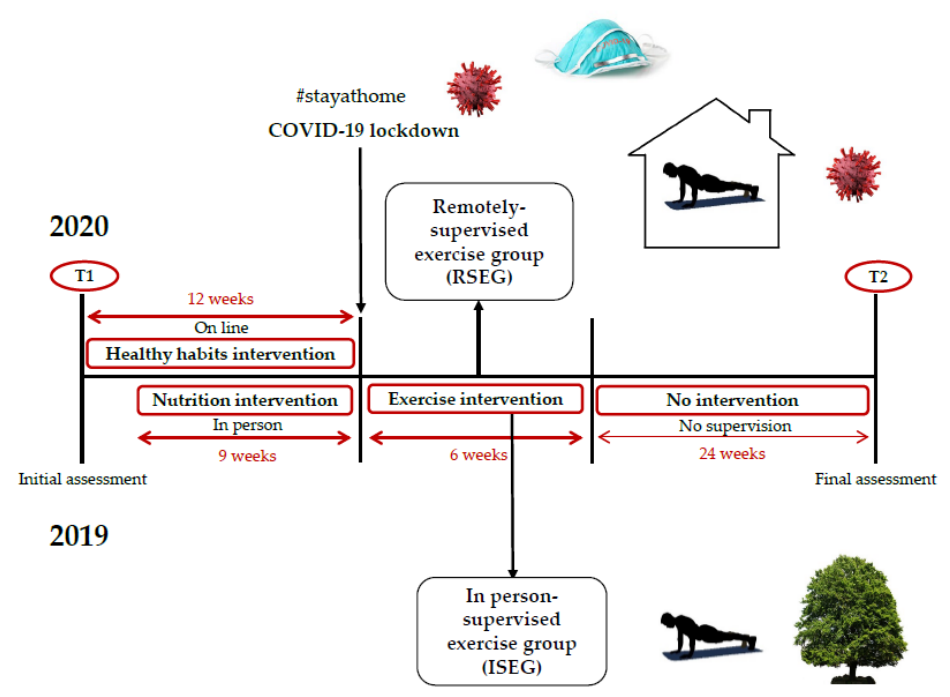
Figure 1. Organization of The Two Lifestyle Interventions.